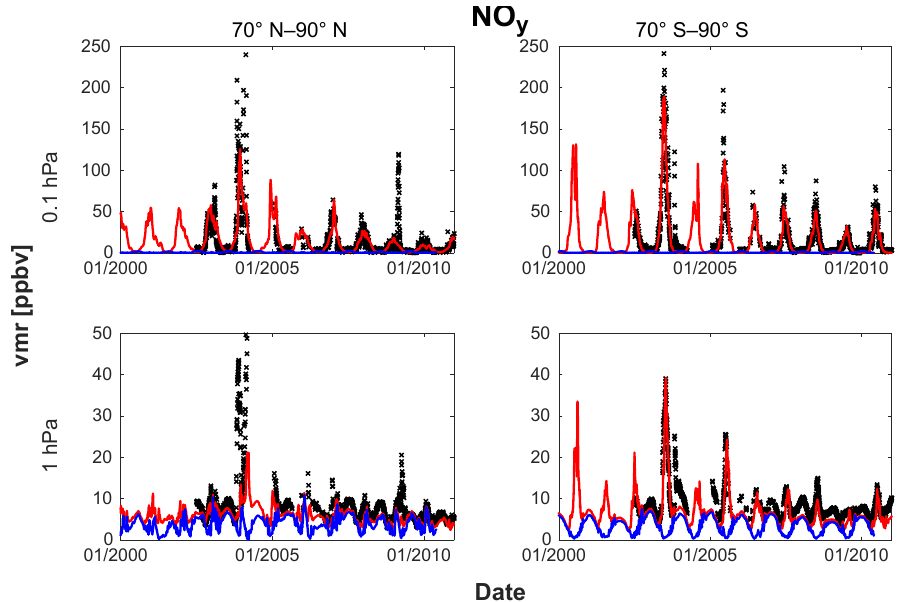
Figure 17. Comparison of NO y from MIPAS observations and different EMAC model runs at 70–90 ◦ N (left) and 70–90 ◦ S (right) for 0.1hPa (upper panel) and 1hPa (lower panel), from 2000 to 2010. Black x’s: MIPAS observations. Red line: EMAC with the MIPAS-derived UBC for NO y (see text). Blue line: EMAC without UBC for NO y .